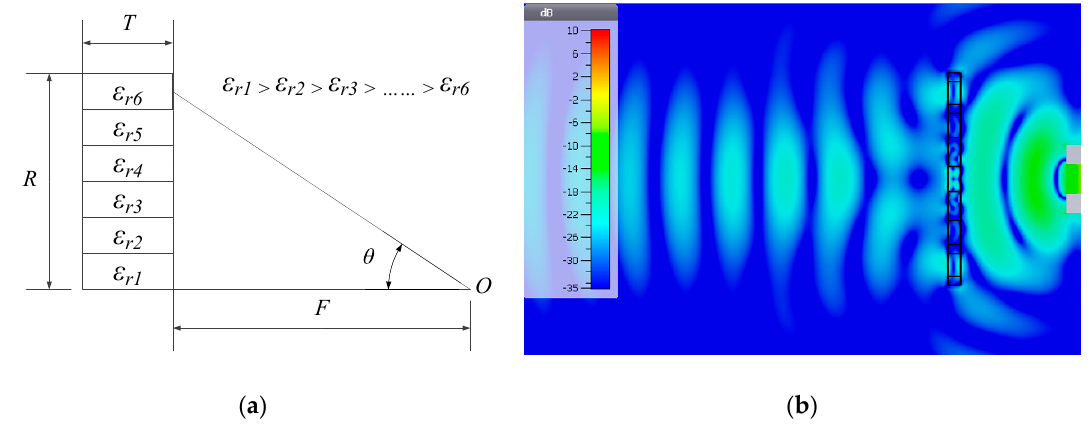
Figure 6. ( a ) Lens design principle; ( b ) Simulated electric field of a ceramic Graded Radial INdex (GRIN) lens that transforming spherical wavefronts into a planar wavefront at 26 GHz.